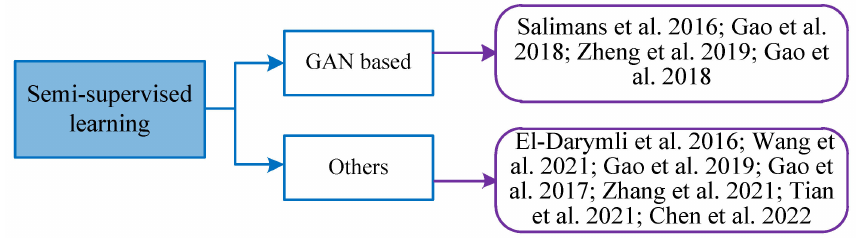
Figure 17. Semi-supervised learning used in SAR ATR